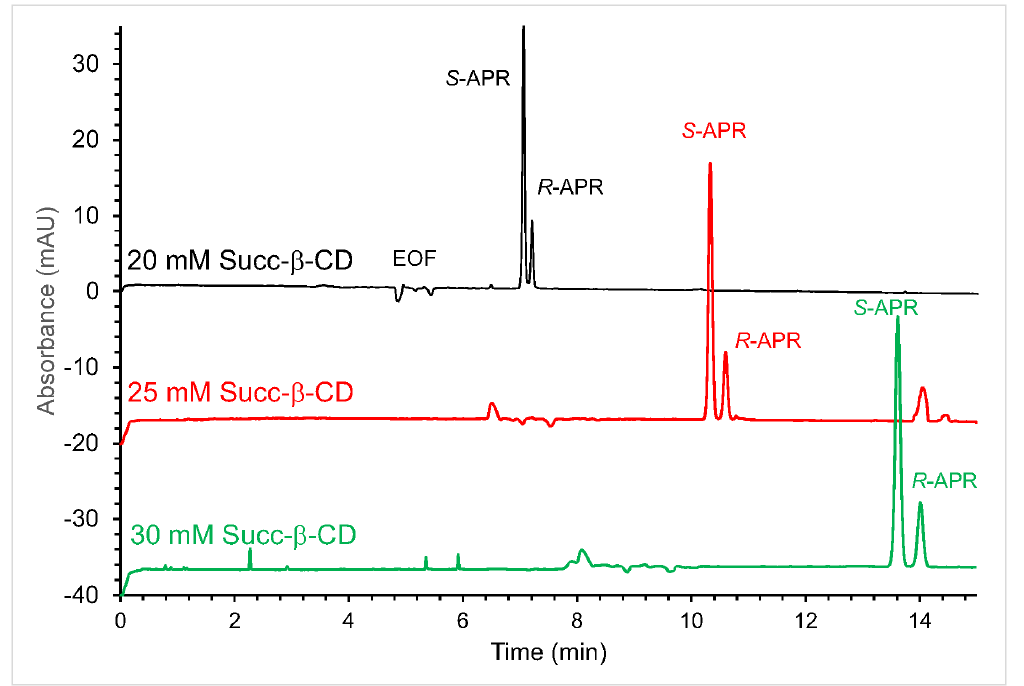
Figure 2. Enantioseparations of APR with Succ- β -CD (DS = 3.5) at 20 mM, 25 mM, and 30 mM. (CE conditions: 50 mM phosphate buffer (pH 7.0), supplemented with the indicated concentration of Succ- β -CD; capillary temperature: 25 °C; hydrodynamic injection: 50 mbar × 2 s; detection: 210 nm and 20 kV).